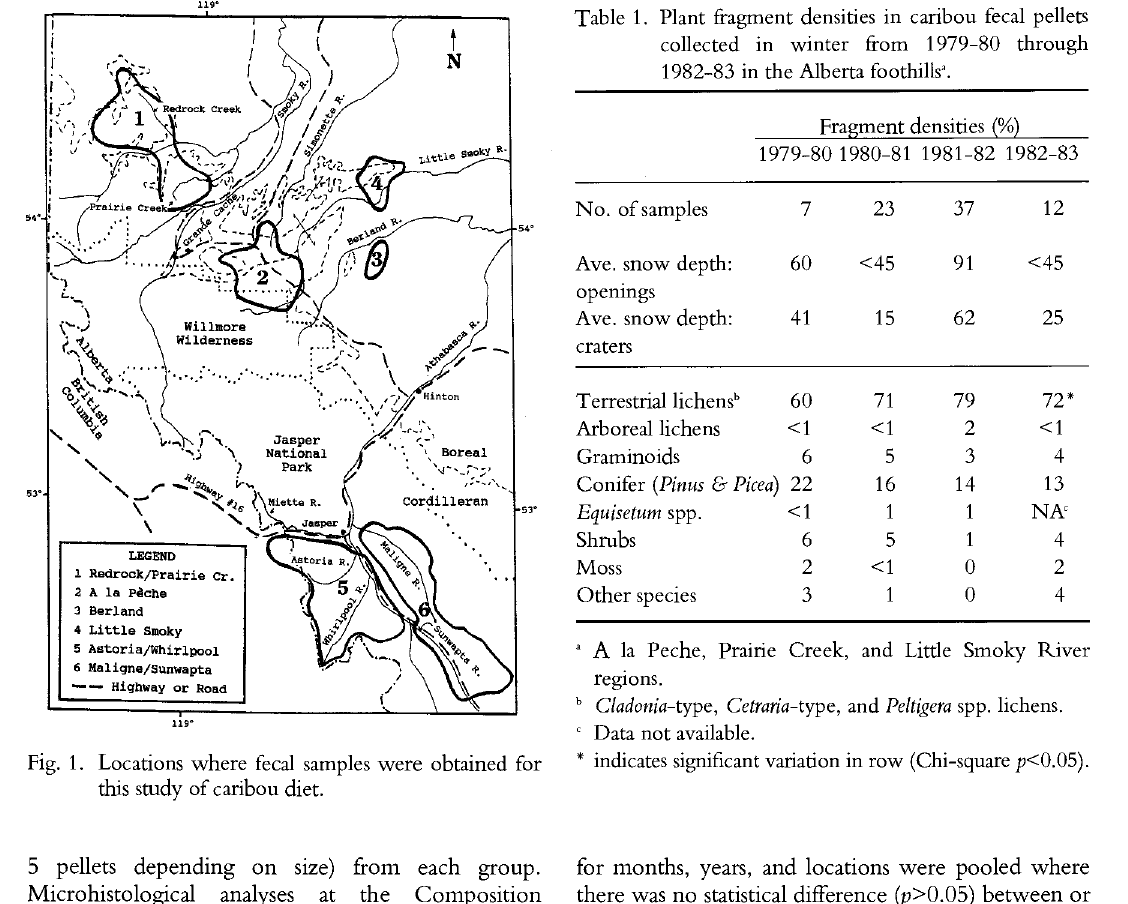
Table 1. Plant fragment densities in caribou fecal pellets collected in winter from 1979-80 through 1982-83 in the Alberta